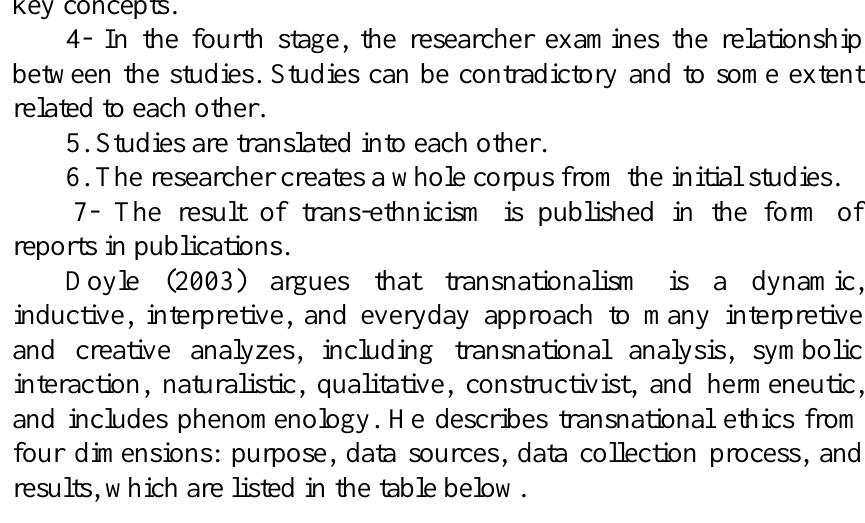
Table 1: Dimensions and characteristics of meta-ethnography (Doyle, 2003).